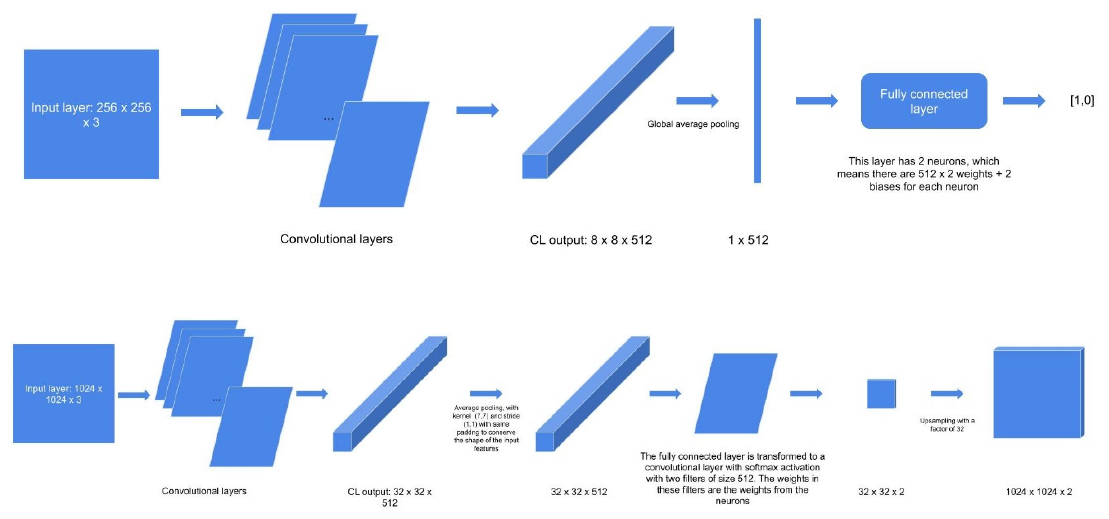
Figure 4. Expansion of the MobileNet model.